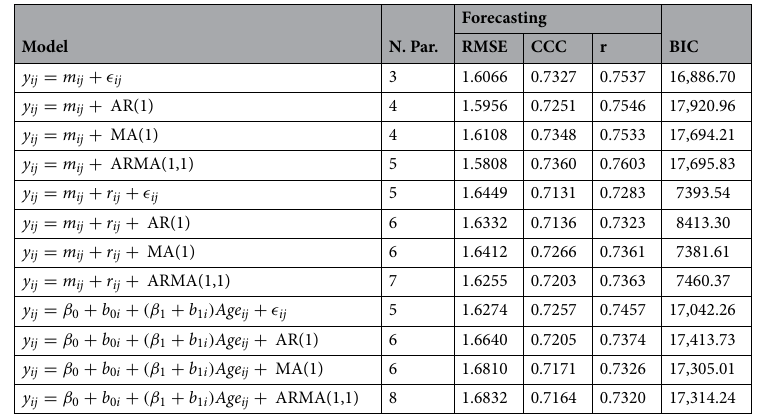
Table 1. Model selection criteria for stages I and II; number of parameters (N. Par.), root mean square error (RMSE), concordance correlation coefficient (CCC), Pearson correlation coefficient (r) between fitted and predicted test data, and Bayesian information criterion